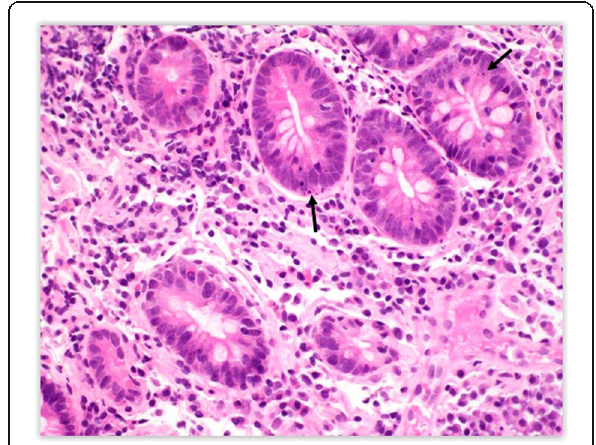
Fig. 2. Multiple crypt apoptotic bodies and fragments of